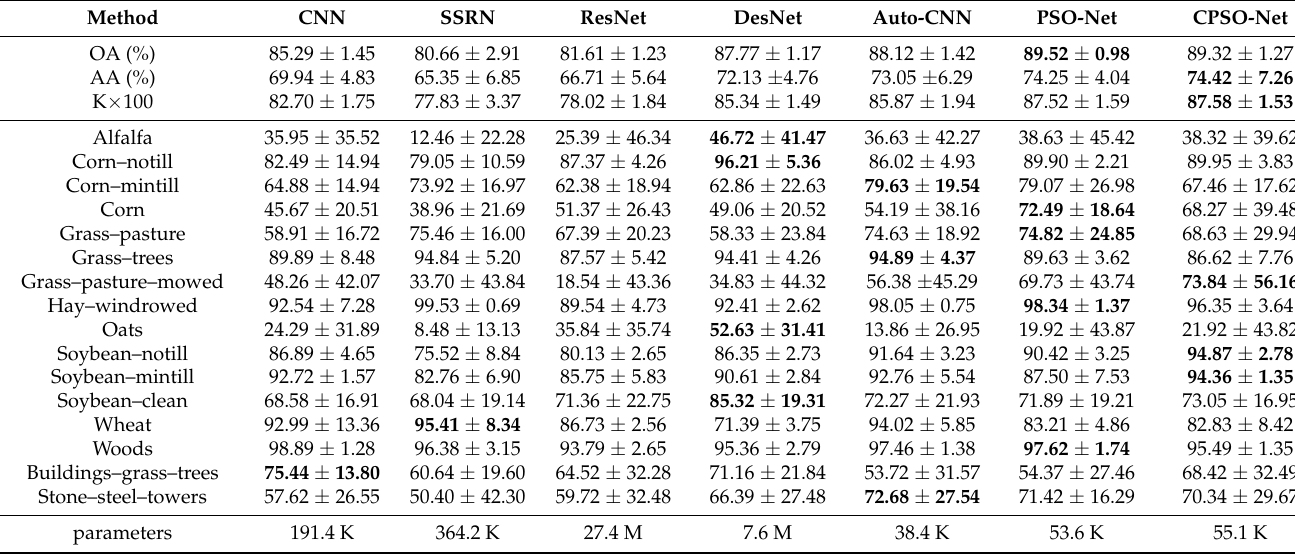
Table 5. Classification accuracy with bolding the best accuracy based on the biased Indian Pines dataset, run five times.